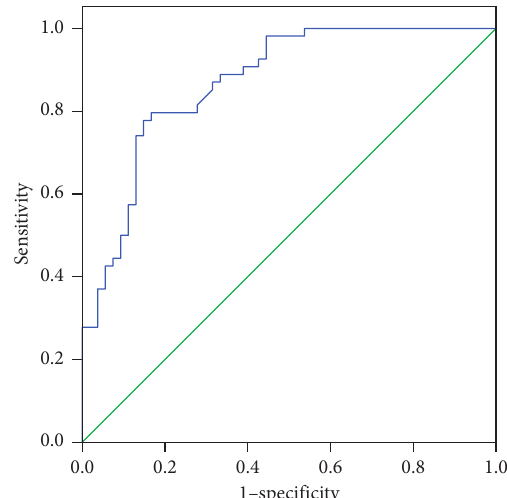
Figure 5: The AUC used as a performance measure of LINC00847 expression in predicting asthma exacerbation from asthma